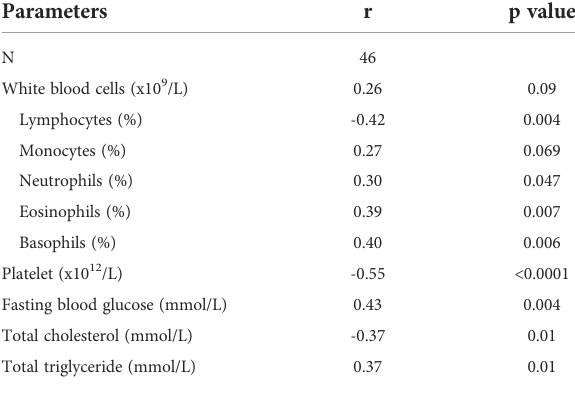
TABLE 4 Univariate correlation analysis in related to IL-10